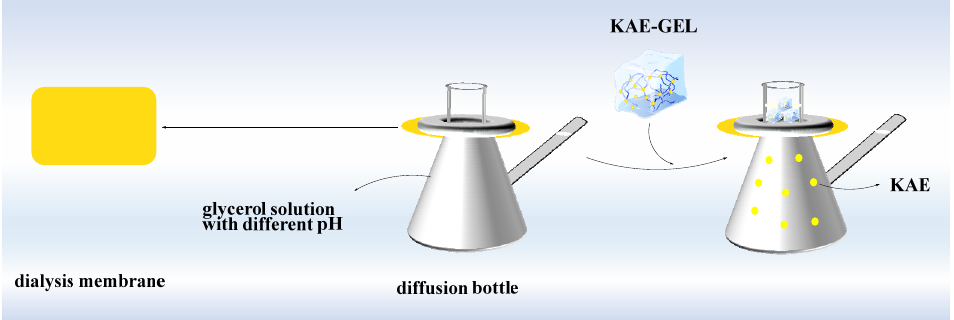
Figure 2. In vitro diffusion study of KAE-GEL through dialysis membrane (MW:8000–14,000) at 37 °C.